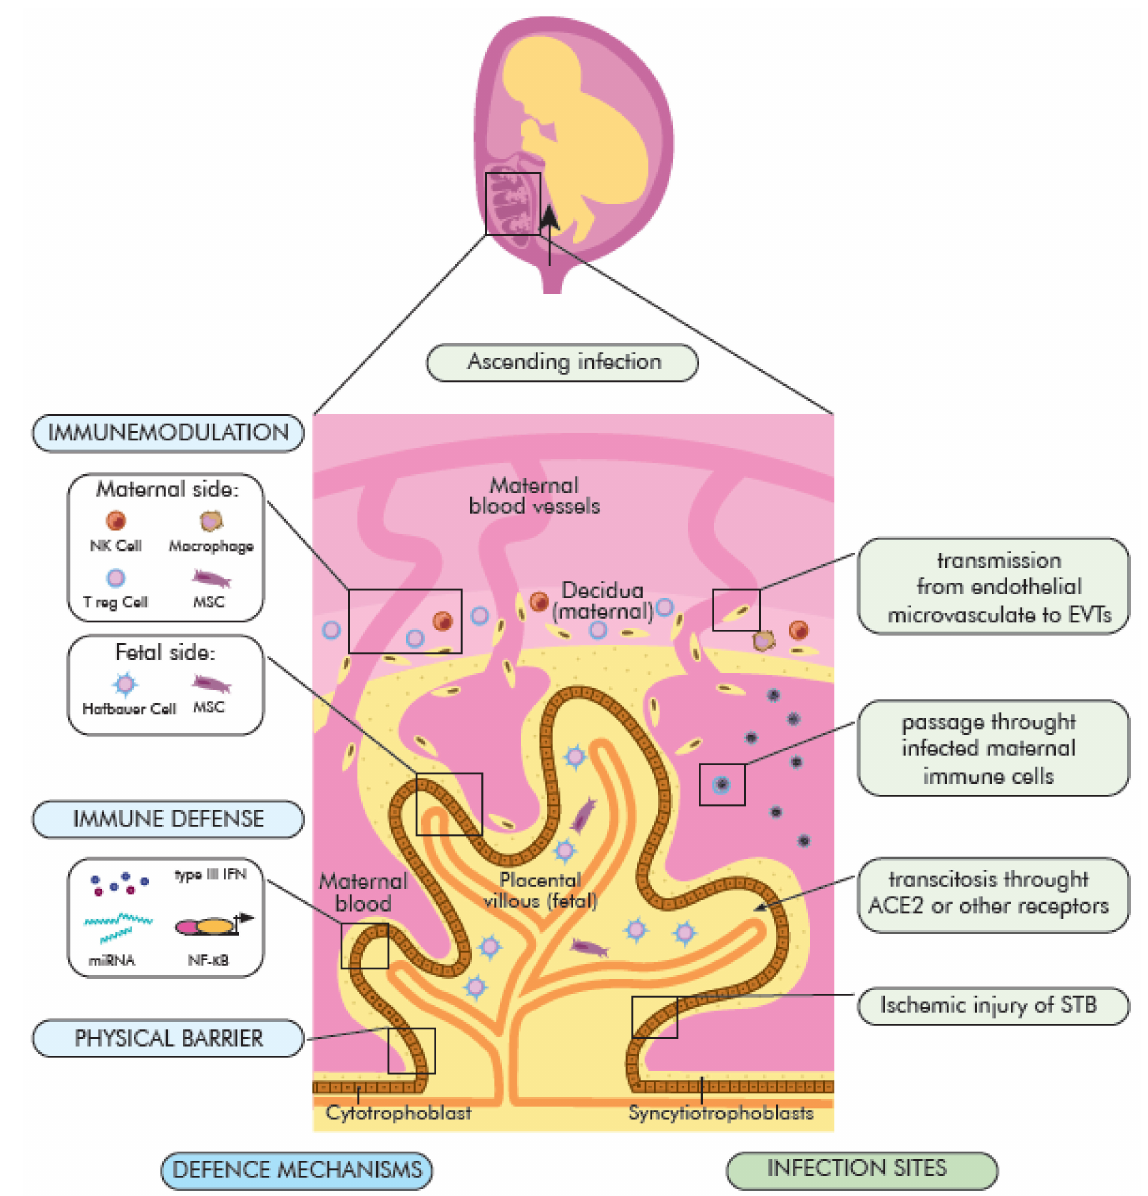
Figure 2. The defense mechanism of the placenta and potential infection sites of SARS-CoV-2. Placental properties that prevent SARS-CoV-2 infection include: Physical blockade, release/synthesis of anti-viral molecules (miRNA, IFN III, NF- κ B), and stimulation of immune defense by decidual and fetal immune cells. The SARS-CoV-2 fetal infection may occur due to placental barrier breakage or via ascending route. Abbreviations: ACE2, Angiotensin converting enzyme 2; EVTs, extravillous trophoblasts; IFN, interferon; miRNA, microRNA; MSC, mesenchymal stromal cells; NF- κ B, nuclear factor kappa-light-chain-enhancer of activated B cells; NK cell, natural killer cell; STB, syncytiotrophoblast; T reg cell, regulatory T